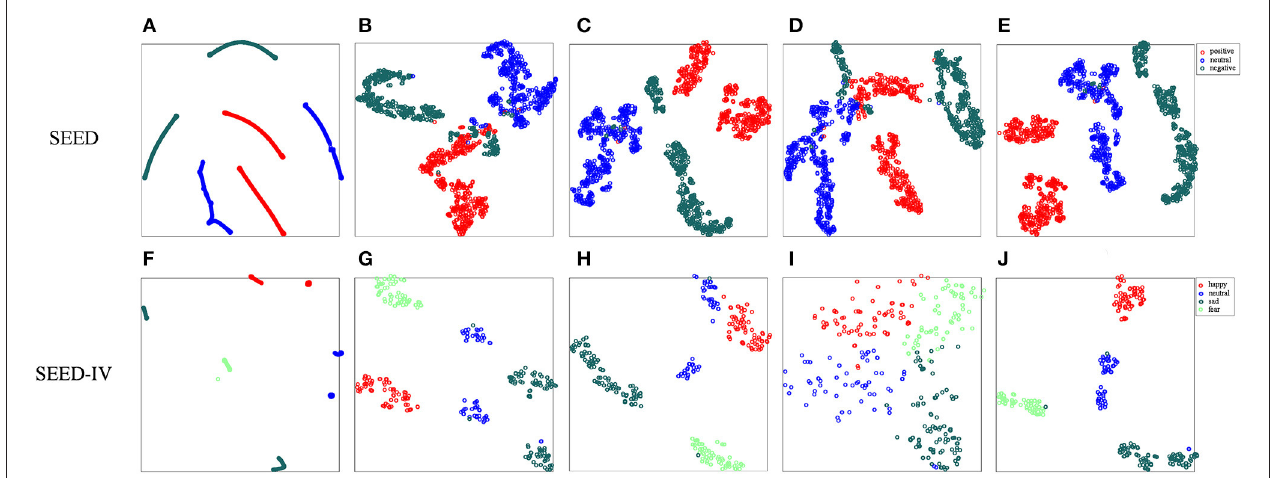
FIGURE 4 | Visualization of t-SNE output from different layers. (A,F) are the original data; (B,G) are the feature distributions output by the first layer of GCN; (C,H) are the feature distributions output by the second layer of GCN; (D,I) is the feature distribution of the output of the convolutional neural network; (E,J) are the feature distributions after connecting the two layers of GCN and SRCNN. Different colors represent different emotions.